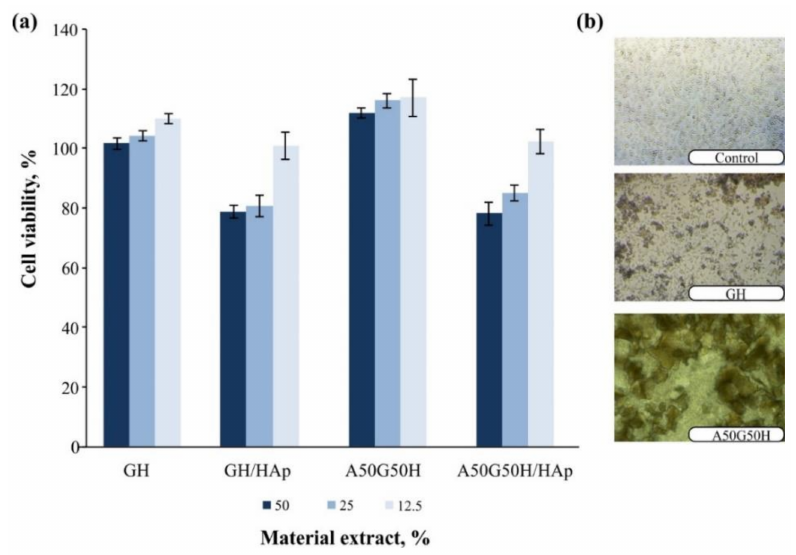
Figure 7. Cell viability upon treatment with extracts of AGH and AGH/HAp hydrogel scaffolds ( a ) and accumulation of cells on its surface ( b ). AGH: alginate, gelatin, and synthetic monomeric component